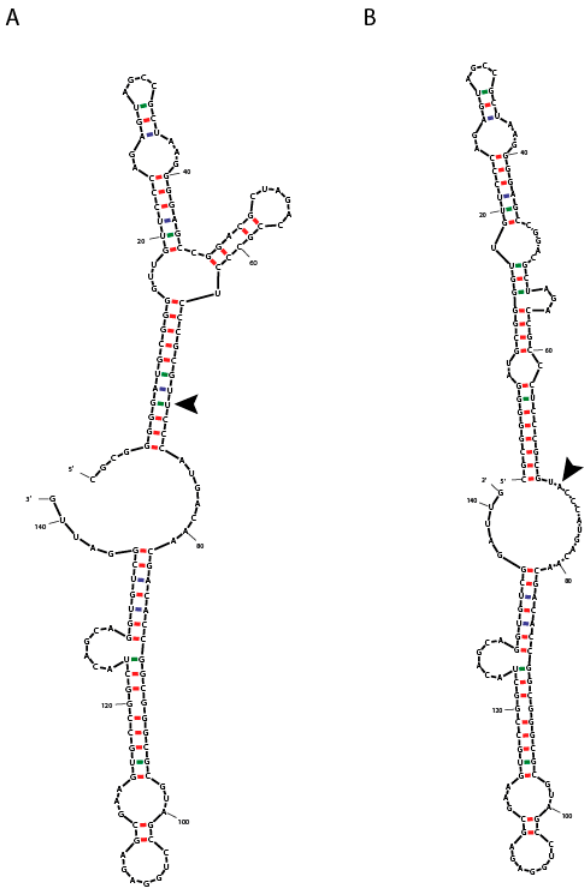
Figure A1. Circle graph of mRNA fragments with the T or A allele at SNP rs1531394. Mfold was used to analyze the effect of rs1531394 on the predicted ANO3 mRNA folding of 141 bp partial sequence: rs1531394 is indicated by an arrowhead with the T allele in ( A ), and A allele in ( B ).